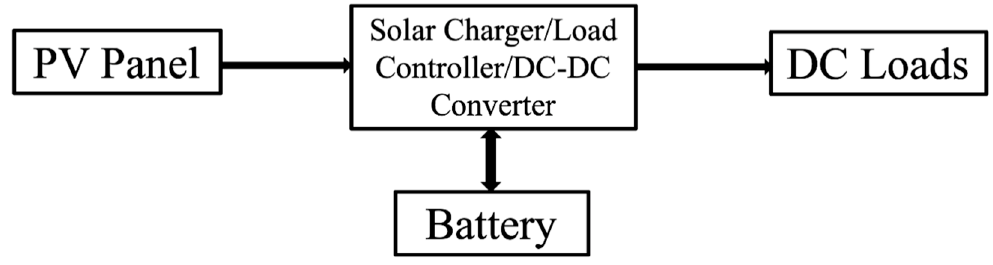
Figure 9. Schematic design of DC Microgrid composed of Solar PV, System Controller and Battery.